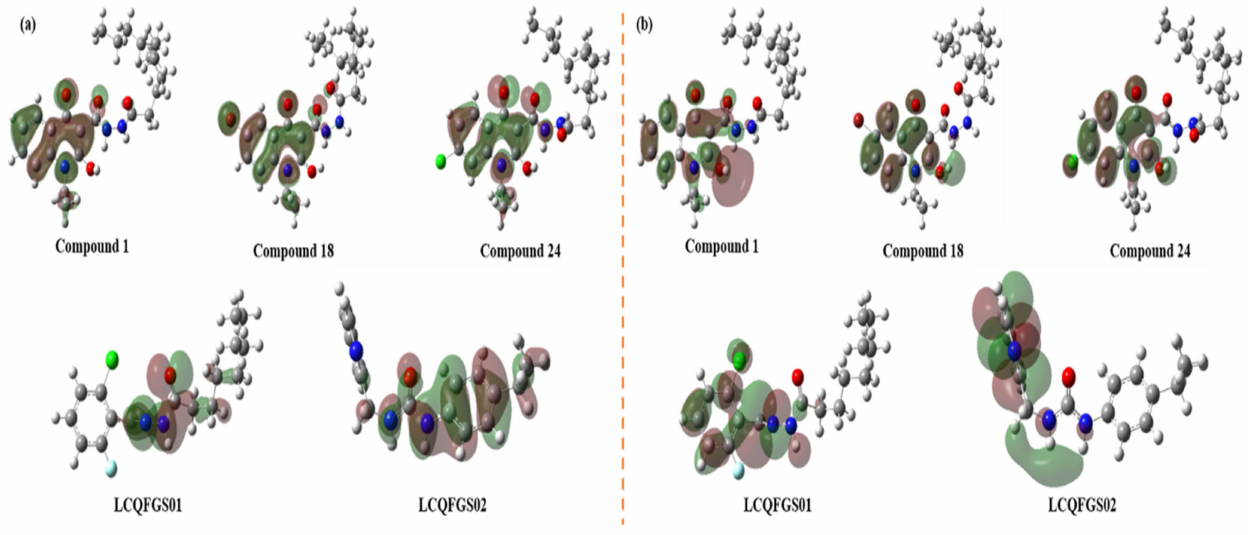
Figure 10. ( a ) HOMO and ( b ) LUMO of compounds 1 , 18 , 24 (most active reference GSK-3 β allosteric modulators) and our two virtual hits, LCQFGS01 and LCQFGS02